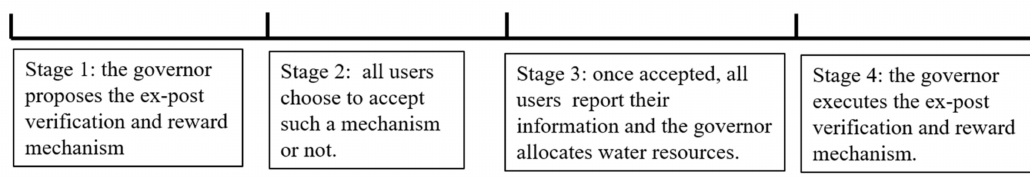
Figure 1. Timeline of the mechanism from the governor’s